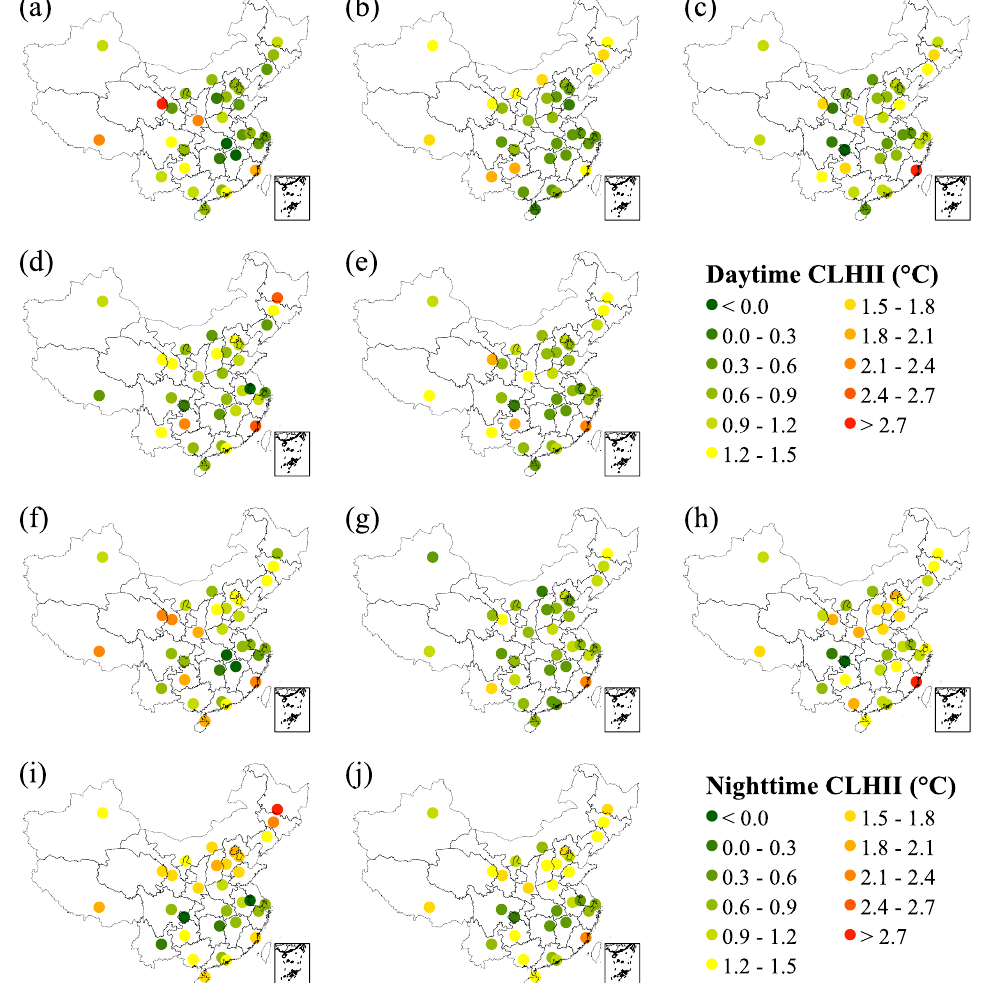
Figure 5. Spatial distribution of CLHII during the period January–December 2009 across China’s 32 major cities, including seasonal variations during the day in ( a ) spring, ( b ) summer, ( c ) autumn, ( d ) winter, and ( e ) annual, and during the night in ( f ) spring, ( g ) summer, ( h ) autumn, ( i ) winter, and ( j ) annual.